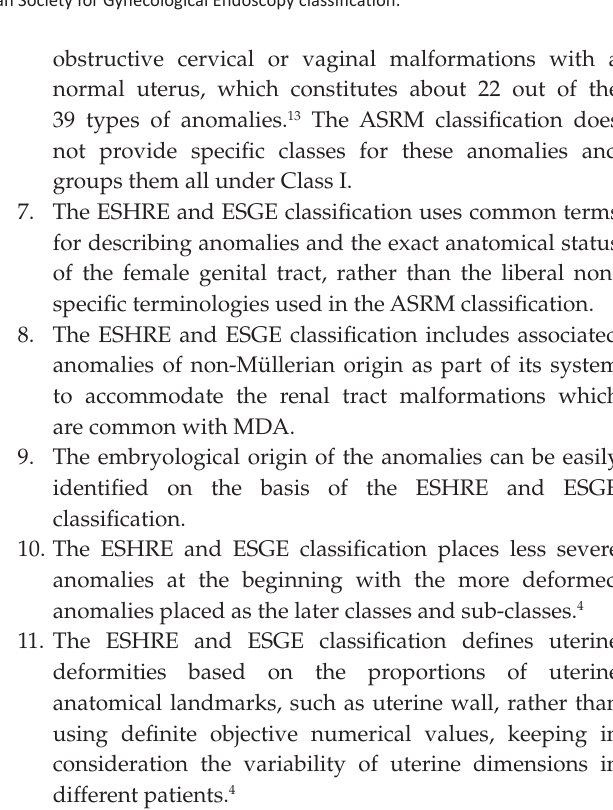
FIGURE 5: The European Society of Human Reproduction and Embryology and European Society for Gynecological Endoscopy classification.